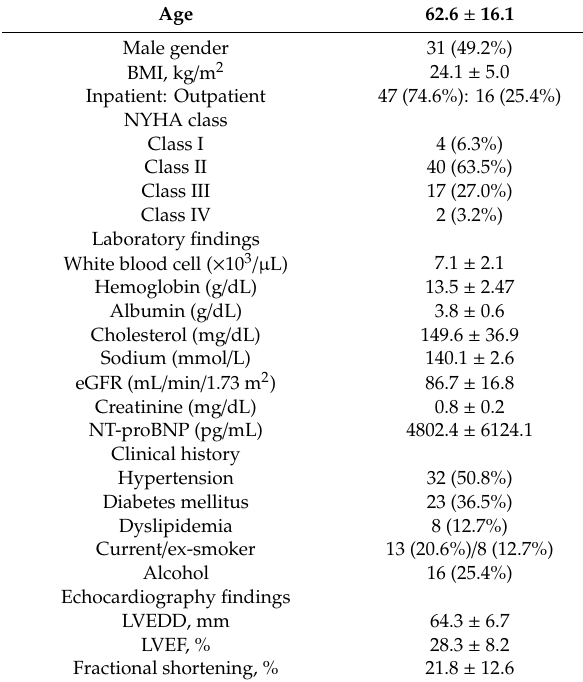
Table 1. Baseline characteristics of the study